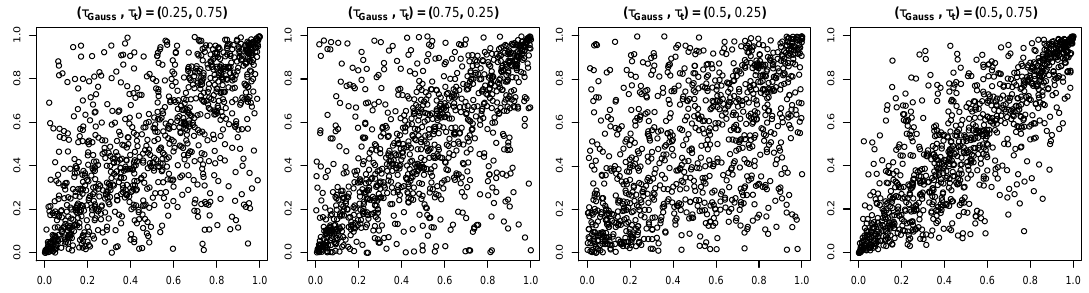
Figure 2: Scatter plots of random samples of size 1000 from the copula based on the mixture of two bivariate elliptical copulas with ( τ G , τ t ) = (0.25, 0.75) , (0.75, 0.25) , (0.25, 0.5) and (0.75, 0.5) (from left to right).